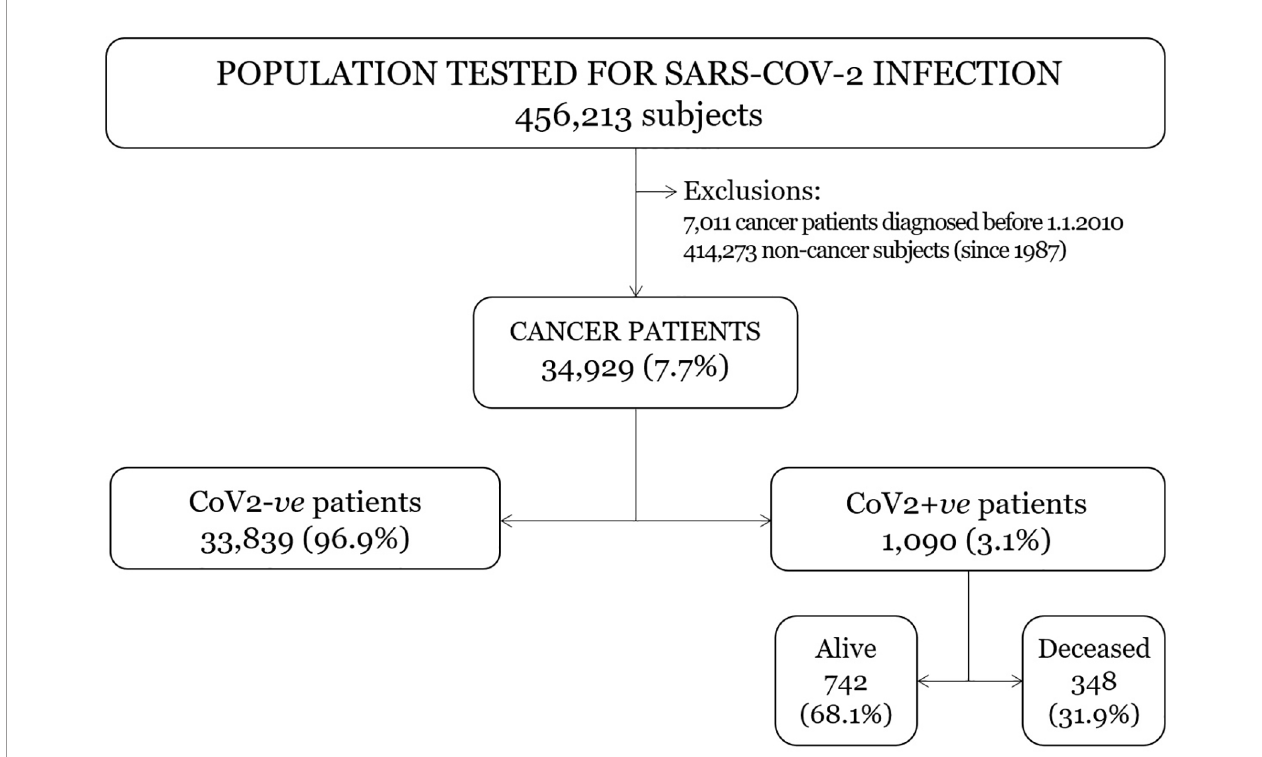
FIGURE 1 | Flow chart of the